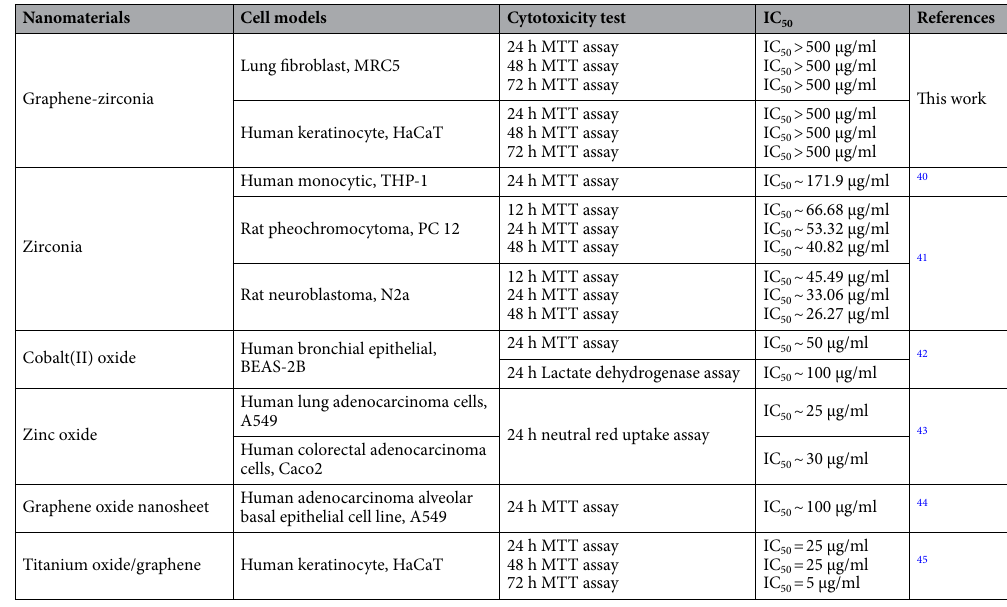
Table 1. IC 50 for nanomaterials commonly used in